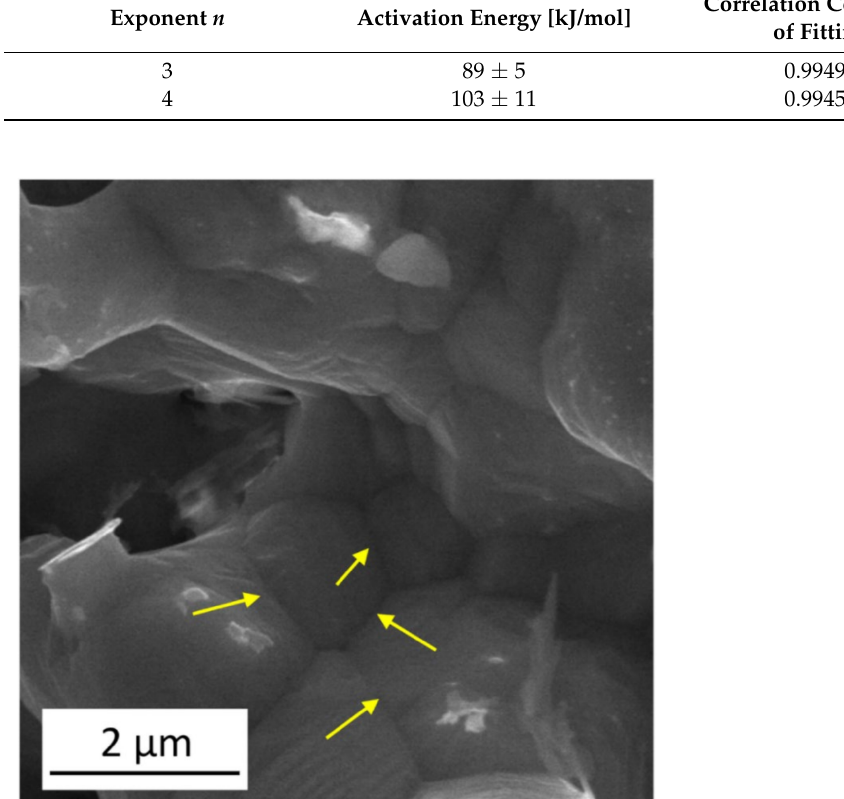
(cid:8)(cid:2) (cid:3) (cid:9) d n − d n T / t 0